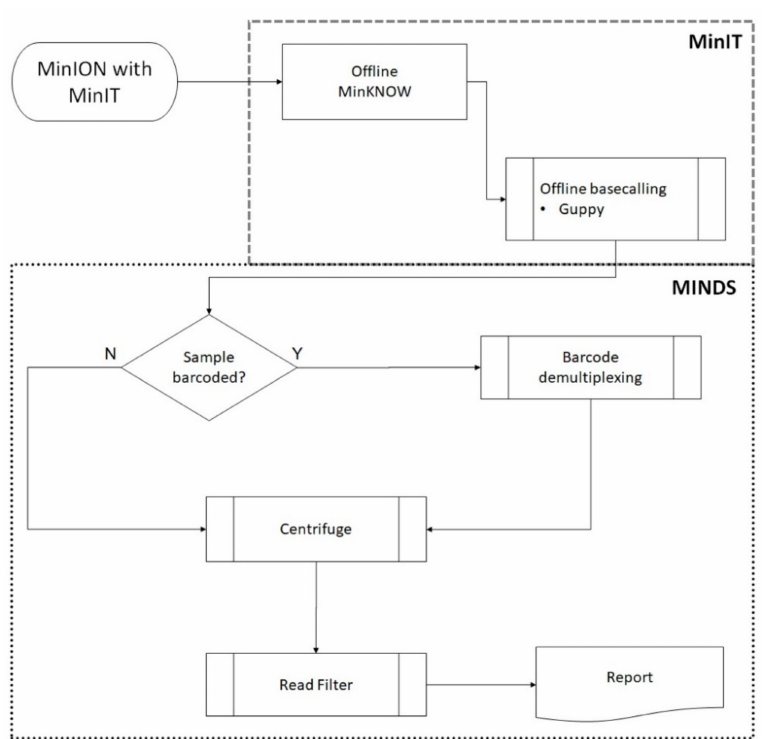
Figure 1. Schematic demonstrating sequencing and bioinformatic workflow. Reads from the MinION wereacquiredwithOxfordNanoporeTechnologies’(ONT’s)MinITreal-timebase-callingdevicerunning MinKNOW and Guppy software. The downstream MINDS workflow processed the metagenomic sequence data read wirelessly from the MinIT to identify microorganisms present in the sample. Barcoded samples were first demultiplexed (if required) using ONT’s qcat software. Centrifuge (Johns Hopkins Center Computational Biology) mapped reads to taxonomic classifications. Background noise was filtered by removing species with only sporadic reads: having less than 0.1% of all total reads mapped and / or having less than 5 unique reads